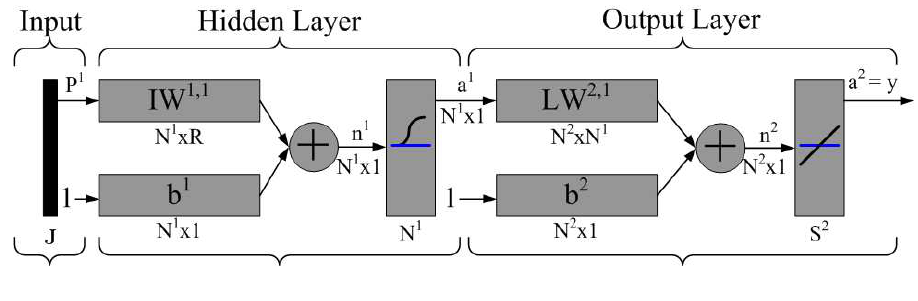
Figure 5. The three-layer perceptron neural network architecture for analyzing the CASA